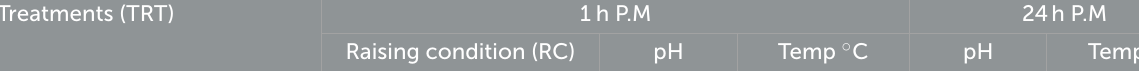
TABLE 3 Effect of the treatments on the pH and core temperature at 1 and 24h postmortem of breast muscle of broiler chickens at d 35 under thermoneutral (TN) and heat stress (HS) raising conditions. Treatments (TRT) 1h P.M 24h P.M Raising condition (RC) pH Temp ◦ C pH Temp ◦ C Effect of interactions between treatments and raising condition (TRT ∗ RC) Control 1 TN